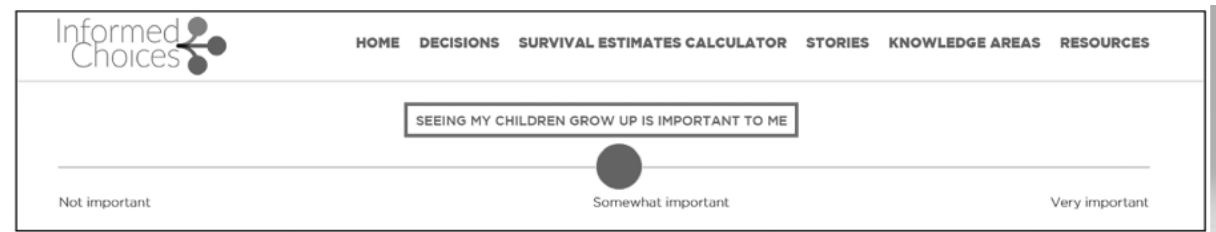
Figure 5. The addition of the phrase “Seeing my children grow up is important to me” to the What’s Important to Me slider will increase the usefulness of the slider for those who want to survive for their children.